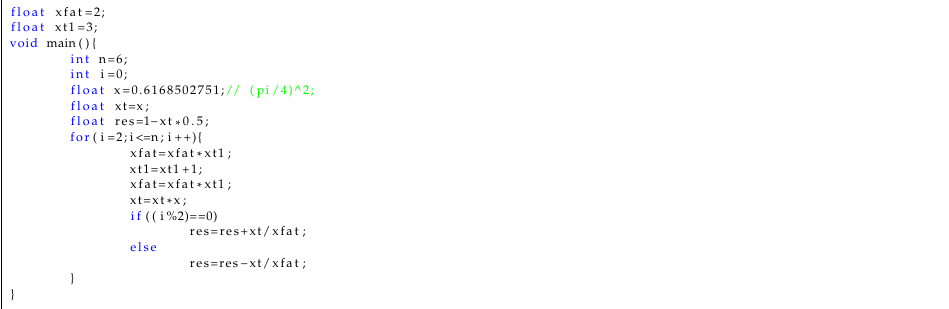
Algorithm 3: Optimized cosine function for hardware